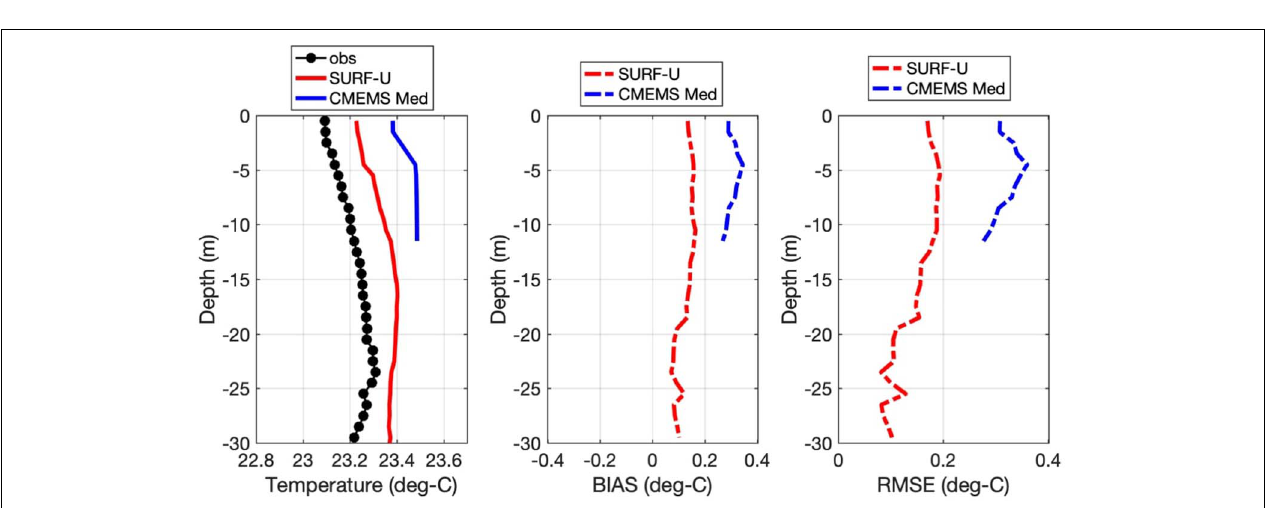
FIGURE 3 | Comparisons between modeled (SURF-U and CMEMS Med) and observed CTD temperature profiles ( left panel ), with BIAS ( middle panel ) and RMSE ( right panel ). The observed temperature (black dotted line) is an average profile over the 31 CTD stations collected during the MREA14 survey in the Taranto Sea.